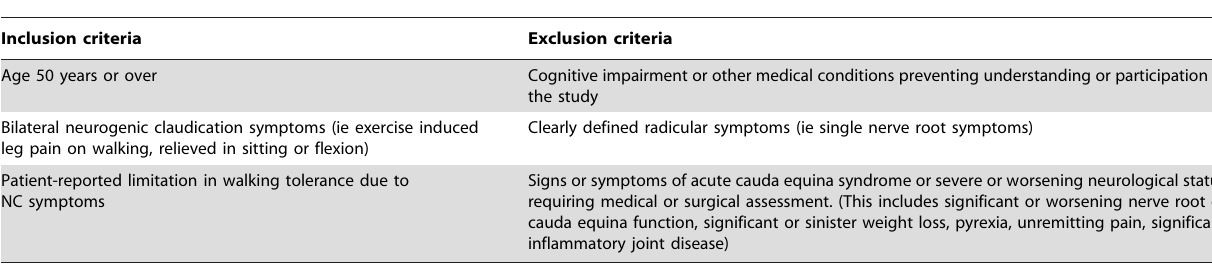
Table 1. Inclusion and exclusion